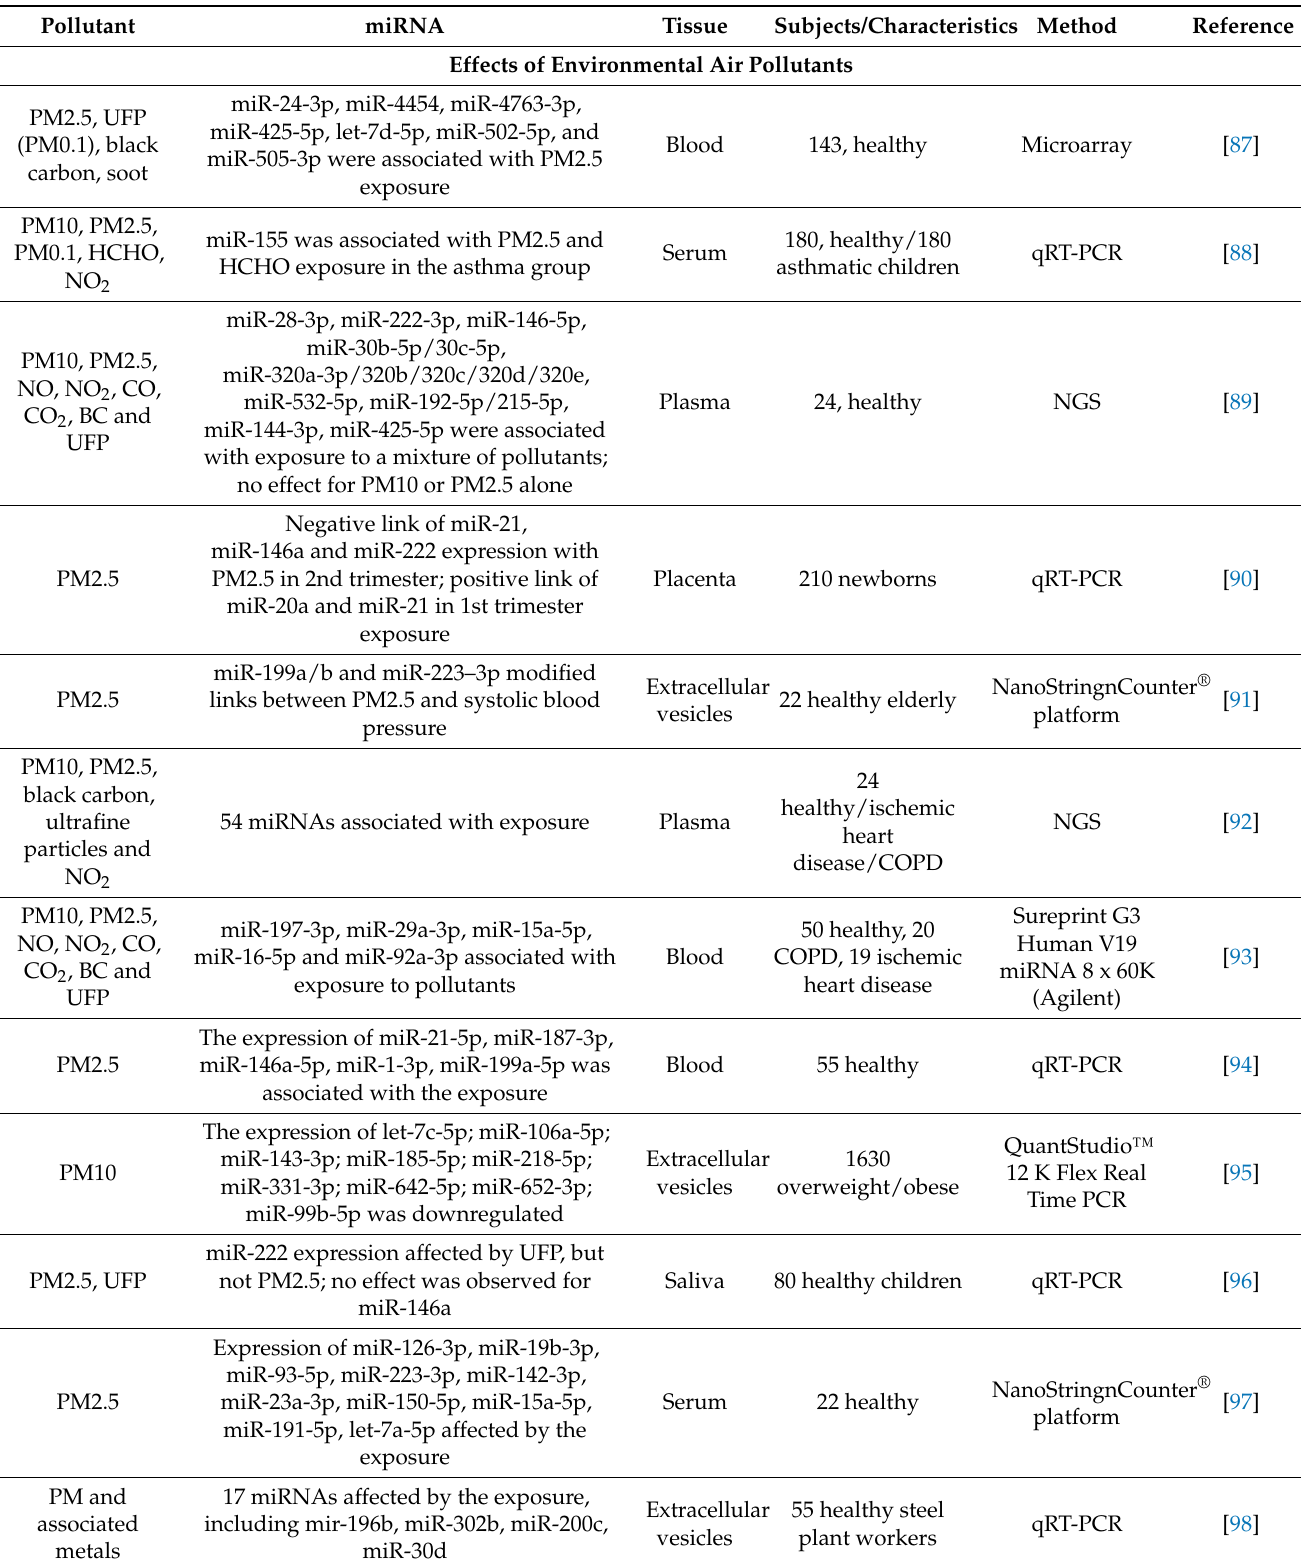
Table 2. An overview of studies focused on links between air pollution exposure and miRNA expression. Pollutant miRNA